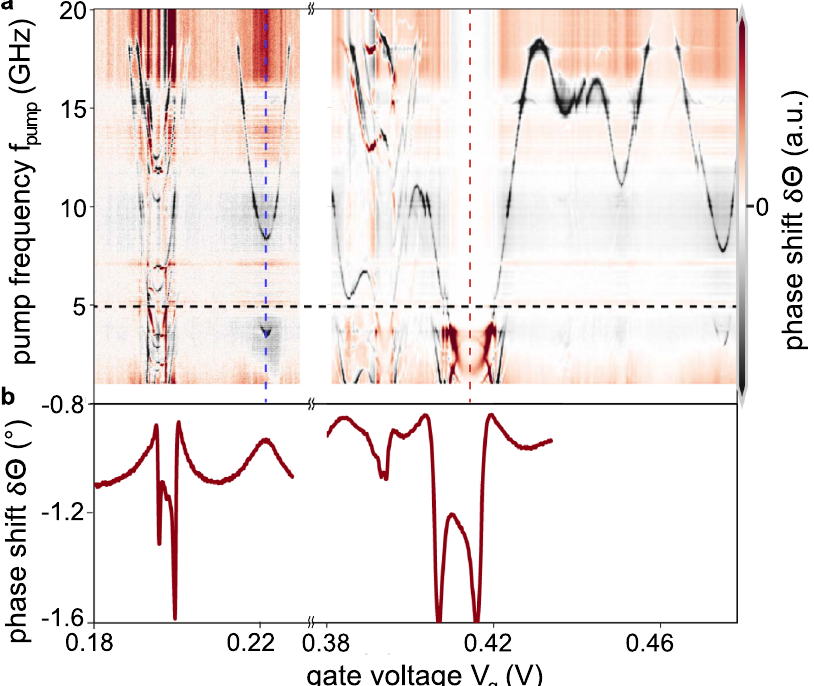
Fig. 5 Gate-dependent Andreev bound state spectrum. a Two-tone spectrum at φ = π in a gate voltage range from 0.18 to 0.23 V and from 0.37 to 0.48 V. The phase shift of the resonator δ Θ is color coded. The probe frequency is indicated by a dashed black line. We assign the abrupt discontinuities in the state dispersion, e.g., around V g = 0.43 V, to random recon fi gurations of the nanowire surface potential or changes in the effective gate charge. The vertical dashed lines indicate the gate voltages chosen for the fl ux-dependent measurements discussed later. b Corresponding resonator phase-shift obtained by single-tone spectroscopy in the same gate voltage range. The slight shifts compared to the measurement in a are caused by a time-dependent gate